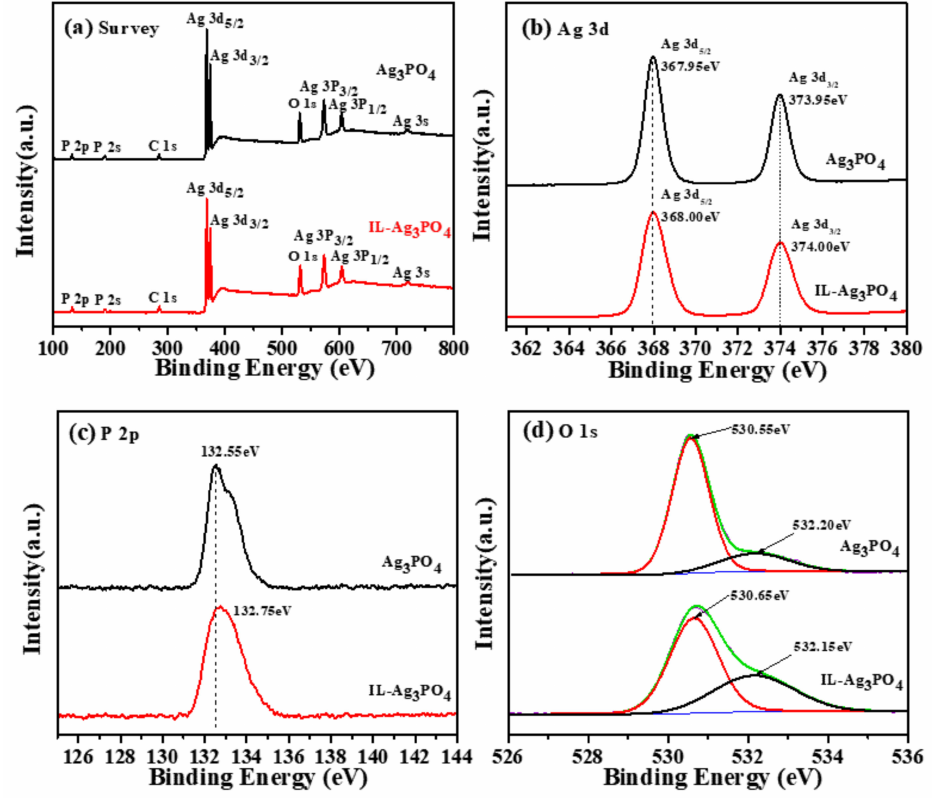
Figure 4. High resolution XPS spectra of ( a ) survey, ( b ) Ag 3d, ( c ) P 2p, and ( d ) O